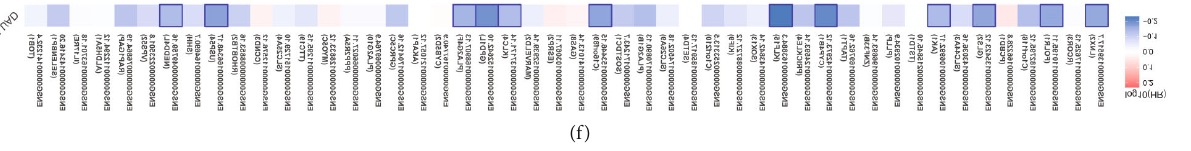
Figure 6: SLC2A5 coexpression genes in LUAD (LinkedOmics database). (a) The global SLC2A5 highly correlated genes were identi fi ed by the Pearson test in LUAD. Red and green dots represent positively and negatively signi fi cantly correlated genes with SLC2A5, respectively. (b) Heat maps and network showing the top 50 genes positively and negatively correlated with SLC2A5 in LUAD. (c, d) Signi fi cantly enriched GO: biological process annotations and KEGG pathways of SLC2A5 in LUAD. (e, f) Survival heat maps of the top 50 genes positively and negatively correlated with SLC2A5 in LUAD. The survival heat maps show the hazard ratios in the logarithmic scale (log10) for di ff erent genes. The red and blue blocks denote higher and lower risks, respectively. The rectangles with frames mean the signi fi cant unfavorable and favorable results in prognostic analyses ( P < 0 : 05